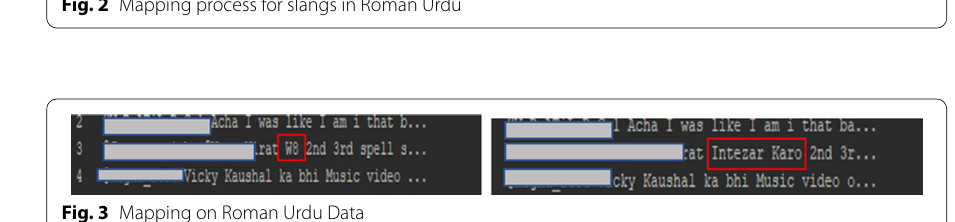
Fig. 2 Mapping process for slangs in Roman Urdu